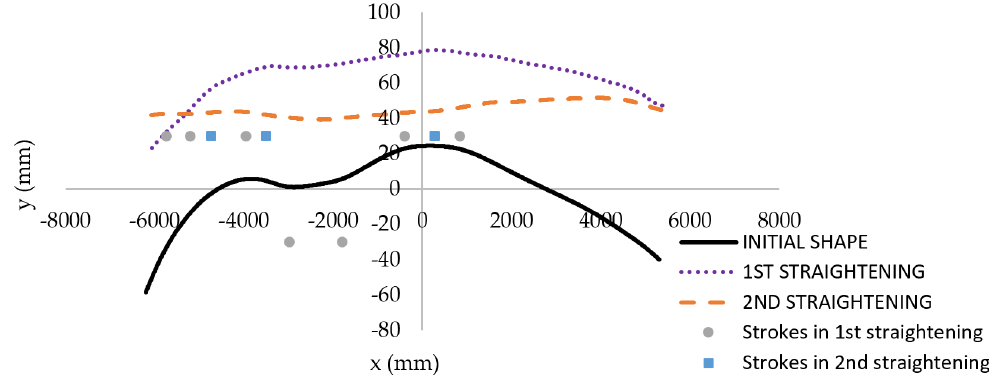
Figure 19. Shape of the “snake-like” exemplary billet before straightening (solid curve), after first straightening (dotted curve), and after second straightening (dashed curve) in regime 1.